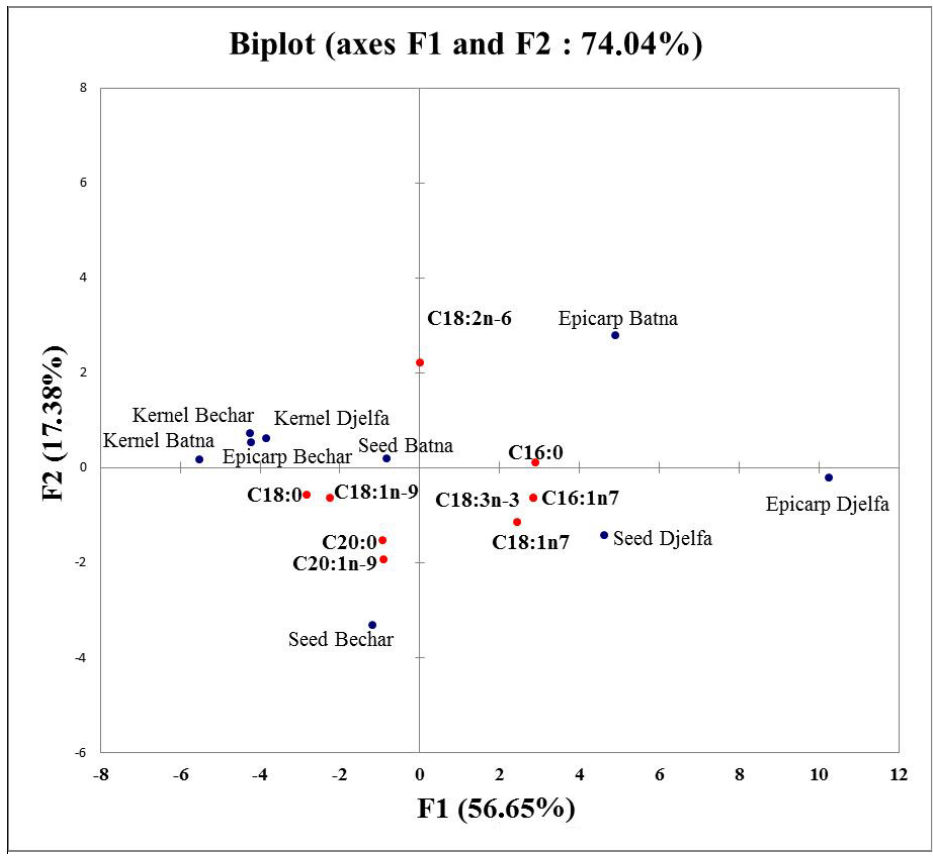
Figure 2. Two-dimensional plot on axes F1 and F2 of the fatty acids content in different parts of Atlas pistachio fruits during two years using PCA.